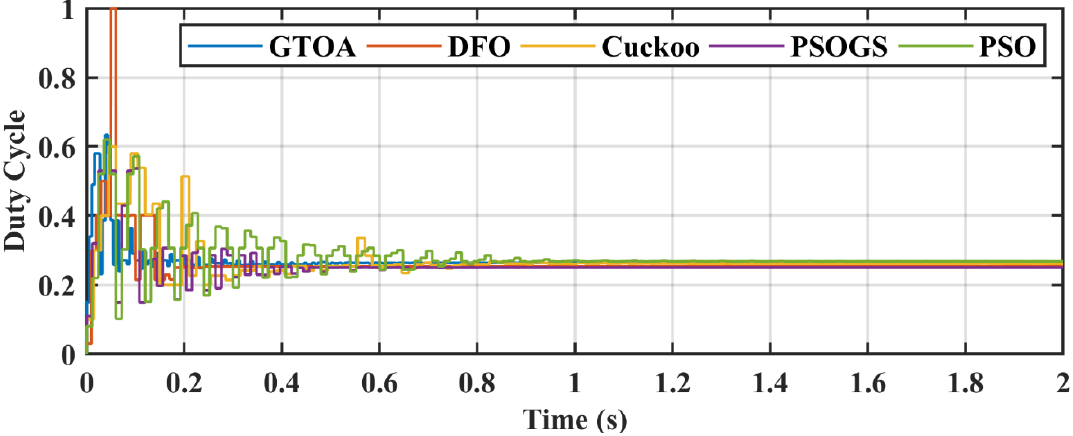
Figure 16. Zoomed-in comparison of power of GTOA.